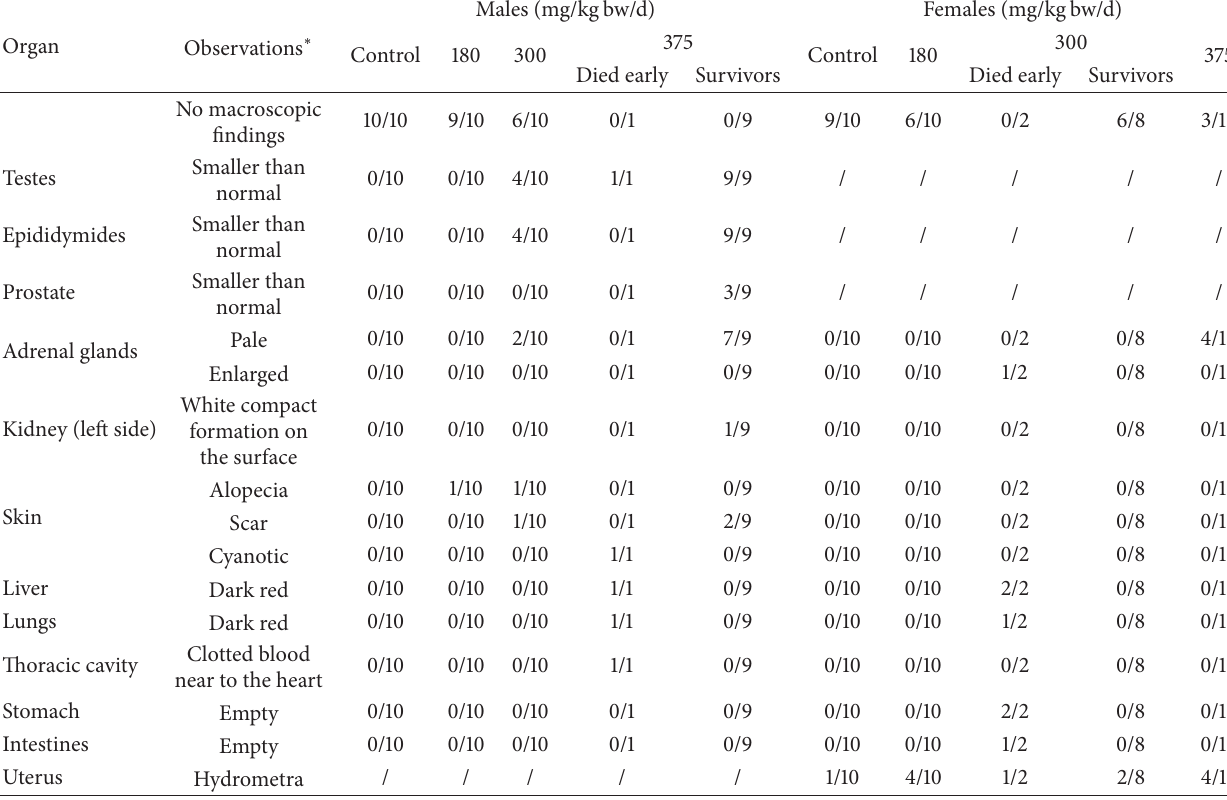
Table 1: Summary of necropsy